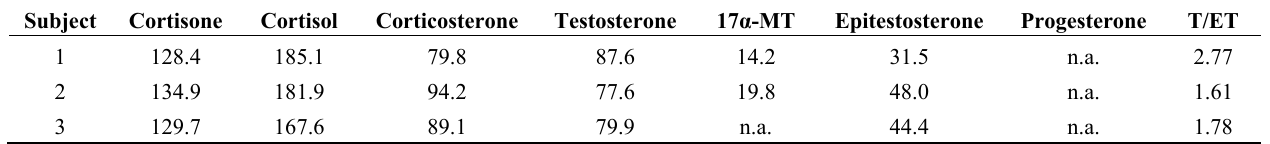
Table 5. The values of concentrations of steroid hormones (in ng mL − 1 ) identified in urine samples of amateur weight-lifters, not using hormonal doping.